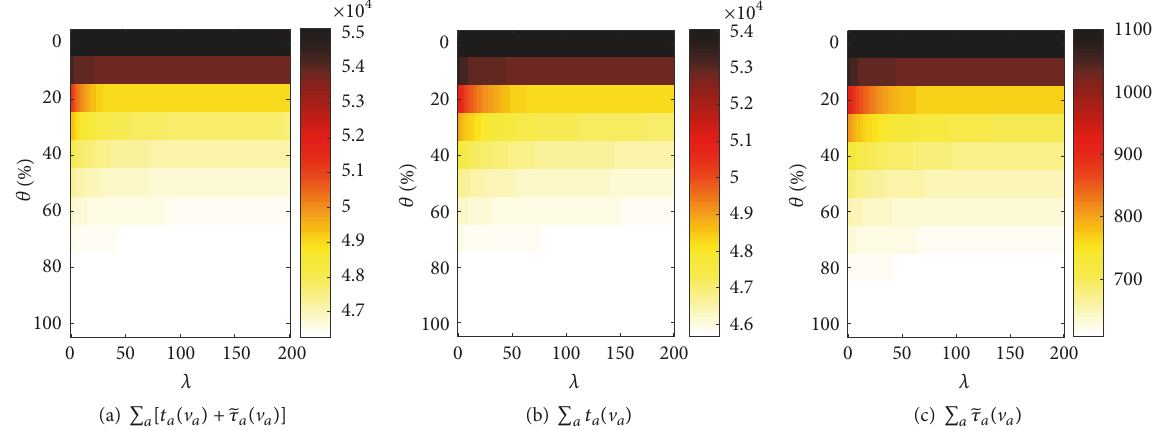
Figure 6: System costs with a common UE and an environmental advocacy CN; (a) total cost; (b) travel time; (c) emission exposure.